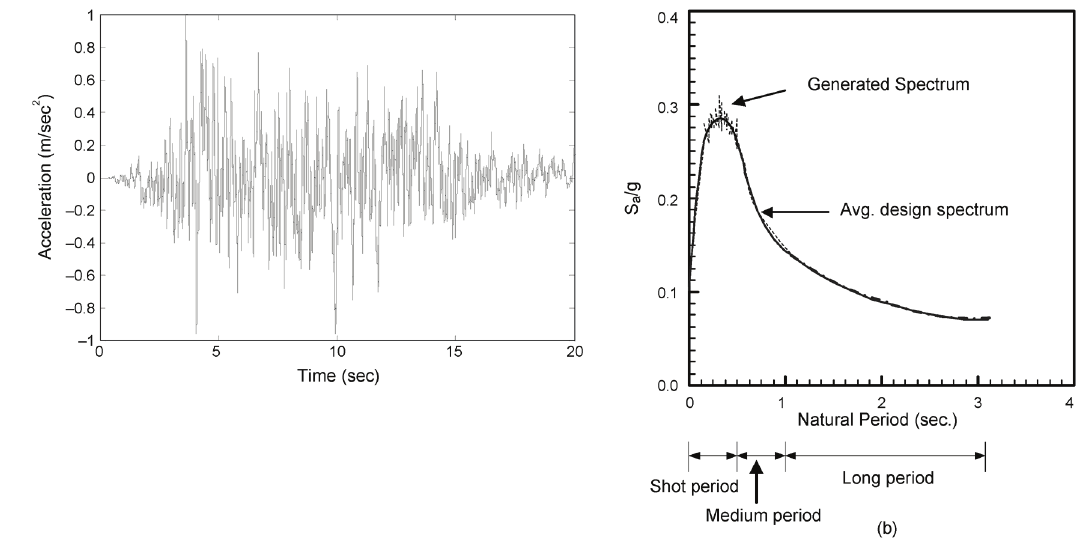
Fig. 4. Synthetic ground motion used in the present study, chosen from literature (Dutta et al. 2004; Dutta, Das 2002): a) acceleration time history; and b) spectrum of simulated ground motion superposed on design spectrum of IS: 1893 (1984) corresponding to 2%